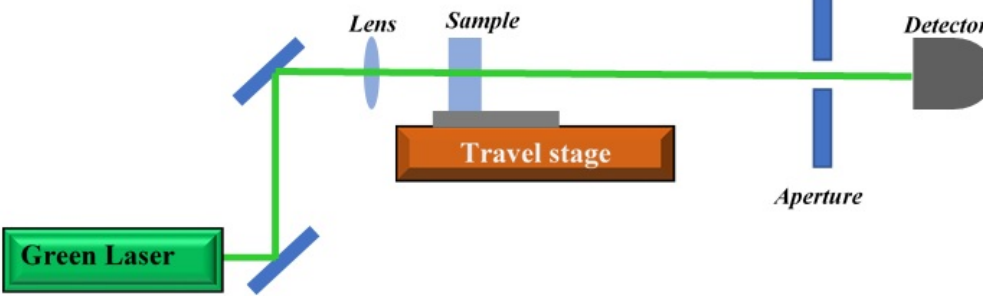
Figure 13. Z-scan setup contains a high-power laser, a traveling stage, an aperture, a mirror, a lens, and a detector. The nonlinear refractive indices of CD and Ag–NPs/CD were measured using high power laser at the wavelength of 532 nm.